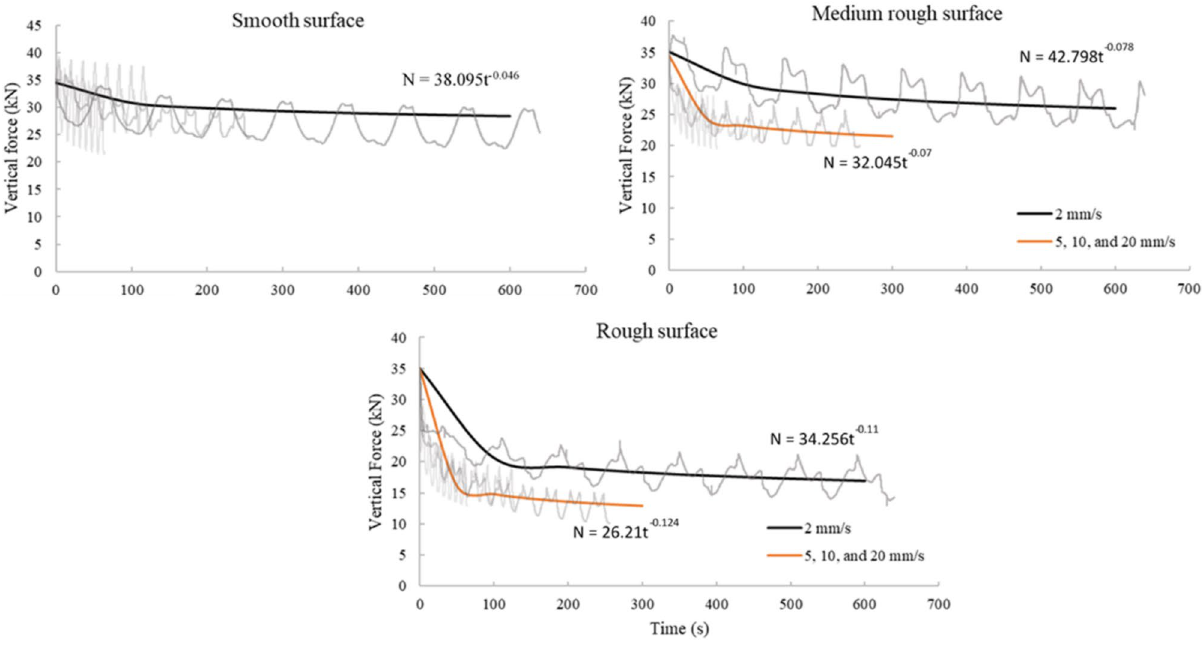
Figure 14. Vertical force trends.